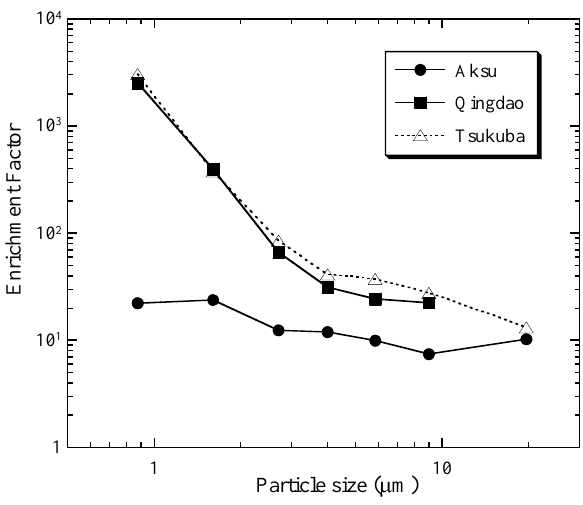
Fig. 4. Enrichment factor (EF) for lead (Pb) in Aksu, Qingdao, and Tsukuba. EF value was calculated y using the following equation: EF=(X/Al) aerosol /(X/Al) crust , where (X/Al) aerosol is the concentra- tion ratio of a given element X to Al in aerosols, and (X/Al) crust is the concentration ratio in the average crustal abundance (Taylor and McLennan, 1985).